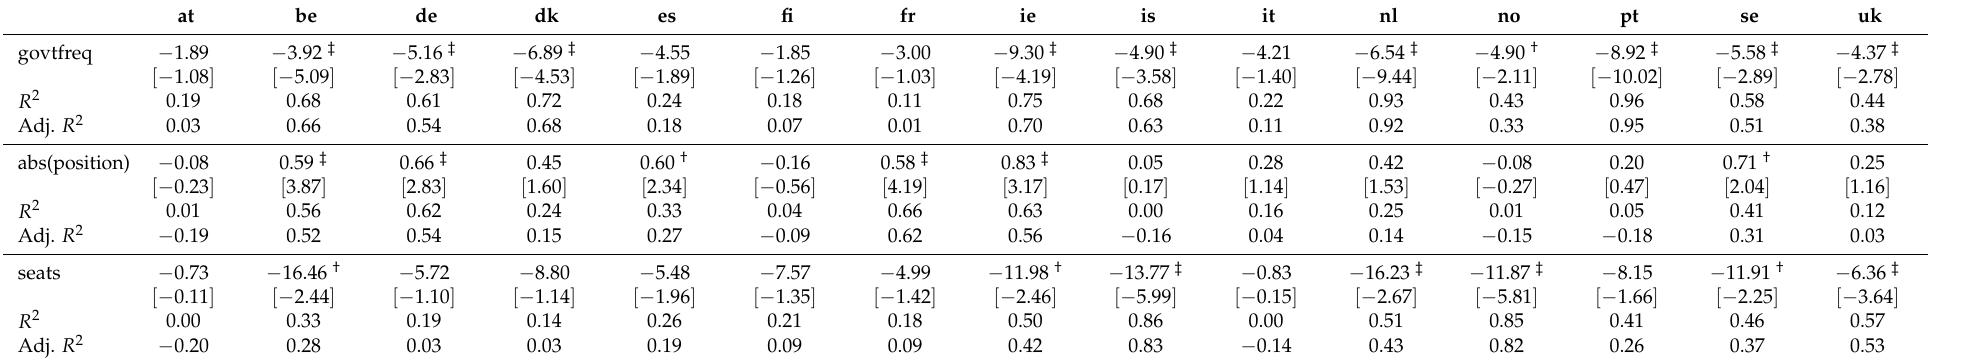
Table A3. Explaining the Preference Parameter (Univariate